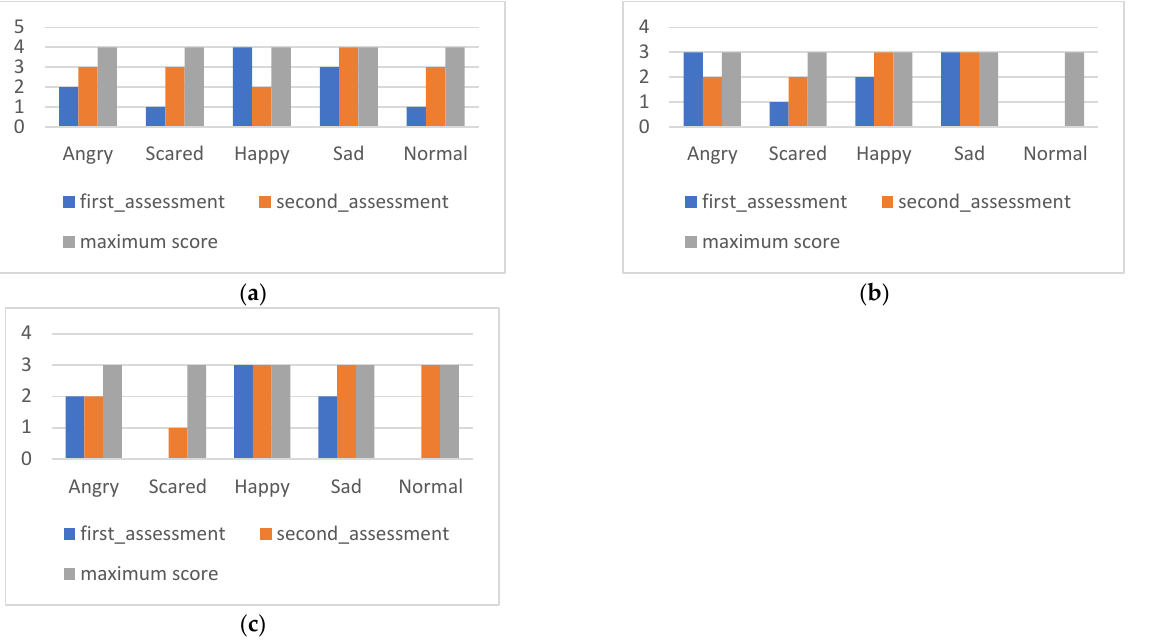
Figure 8. Nuno’s ACES subscales : ( a ) facial expressions; ( b ) situations; ( c ) behaviors.